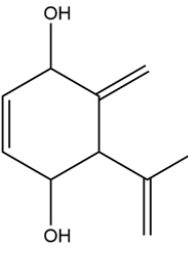
Figure 1. Piquerol chemical structure.